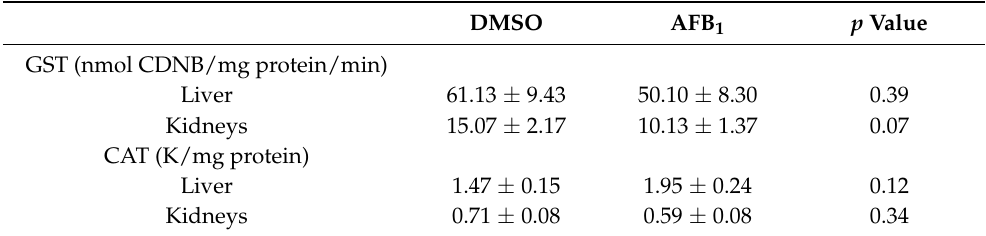
Table 1. Effect of intermittent administration of AFB 1 (250 µ g/kg b.w., i.g.) or 2% DMSO (10 mL/kg b.w., i.g.) on GST and CAT activity in liver and kidneys.